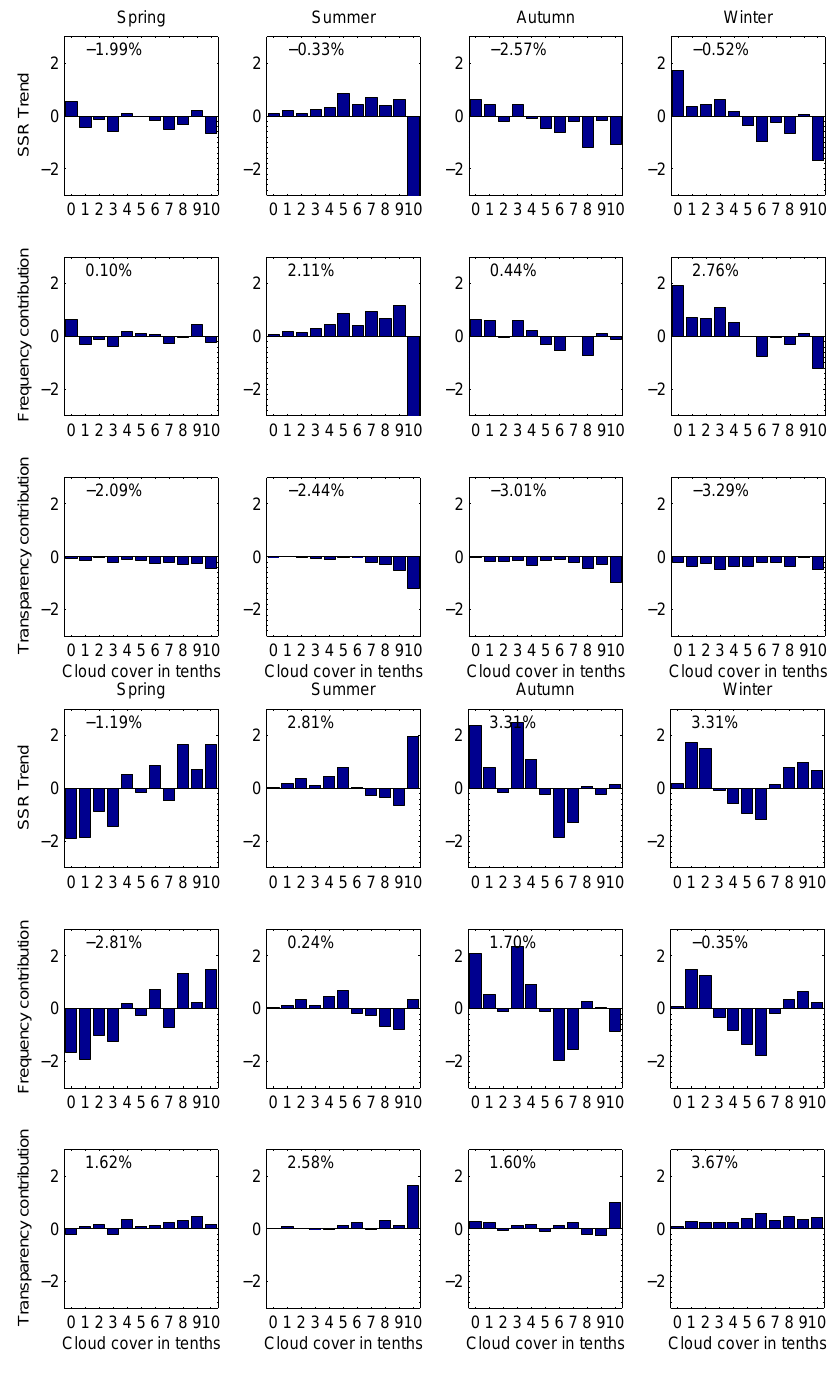
Fig. 9. The same as in Fig. 8, but in Southwest